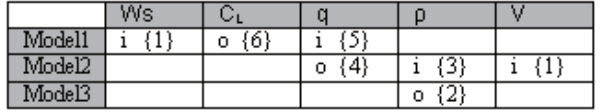
Fig. 3. Final populated incidence